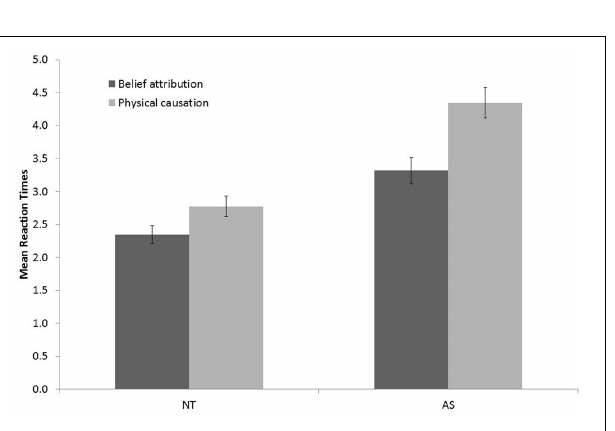
FIGURE 3 | Mean Reaction times, RTs (in seconds) depending on Group (NT and AS) and ± ToM condition (Belief Attribution and Physical Causation).